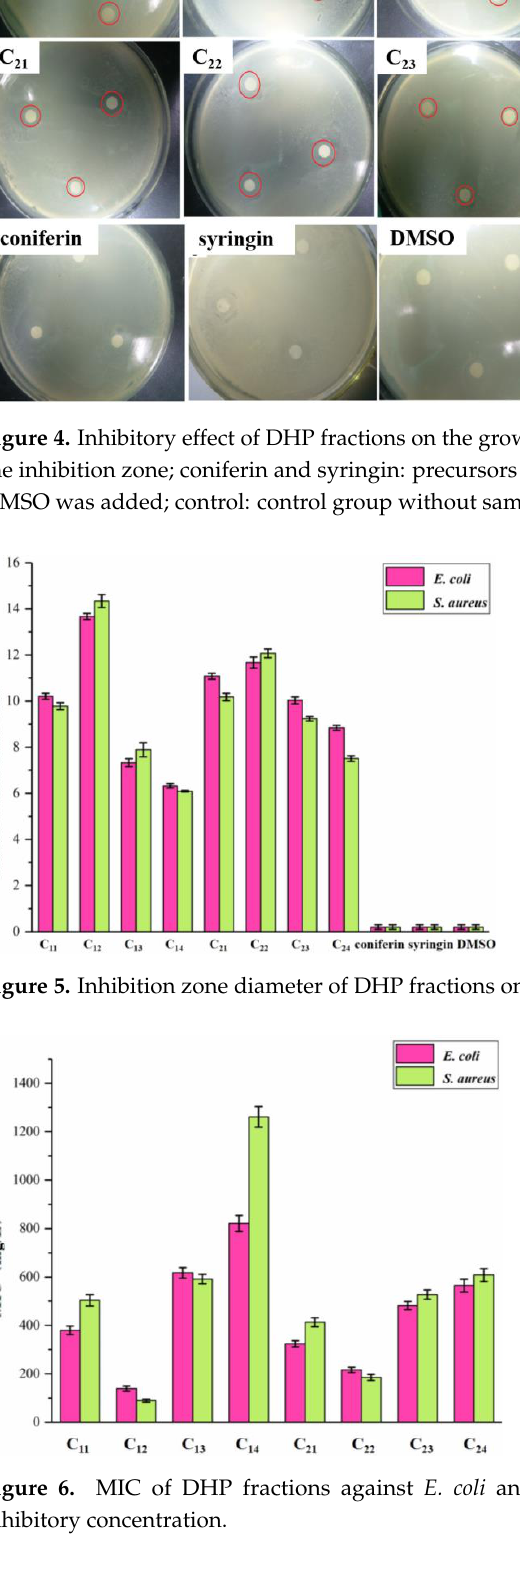
Figure 6. MIC of DHP fractions against E. coli and S. aureus. Legend: MIC: the minimum inhibitory concentration.